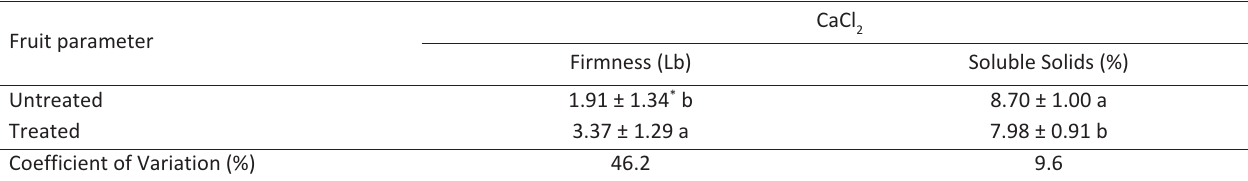
* Standard deviation. Values followed by the different lowercase letter in a column are significantly different from each other (P<0.05).